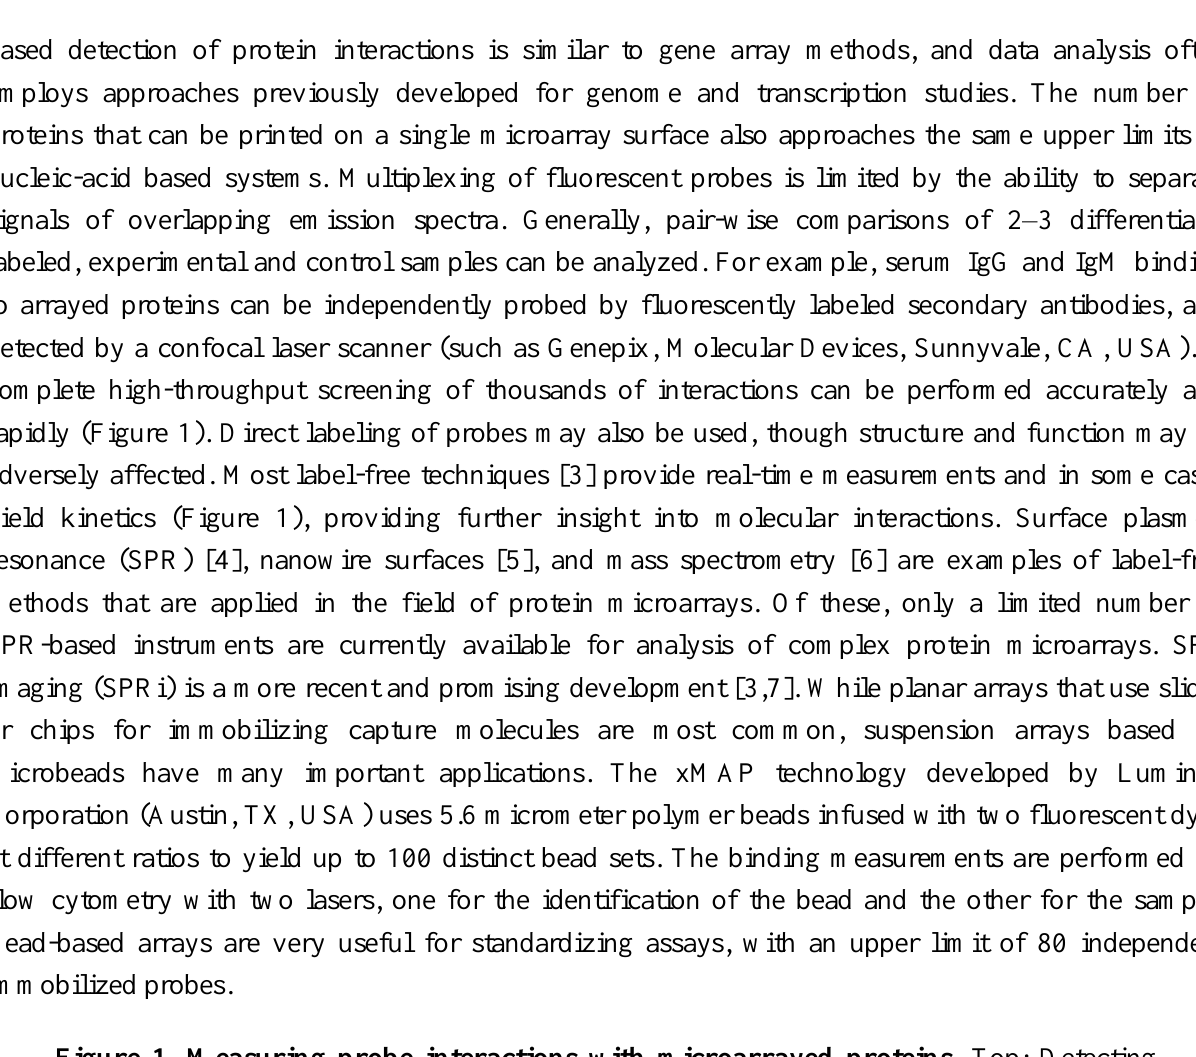
Figure 1. Measuring probe interactions with microarrayed proteins . Top: Detecting binding events using a fluorescently-labeled secondary probe, such as an antibody, and the resulting laser-scanned image. Bottom: Label-free interactions detected by surface plasmon resonance, resulting in a sensorgram of binding